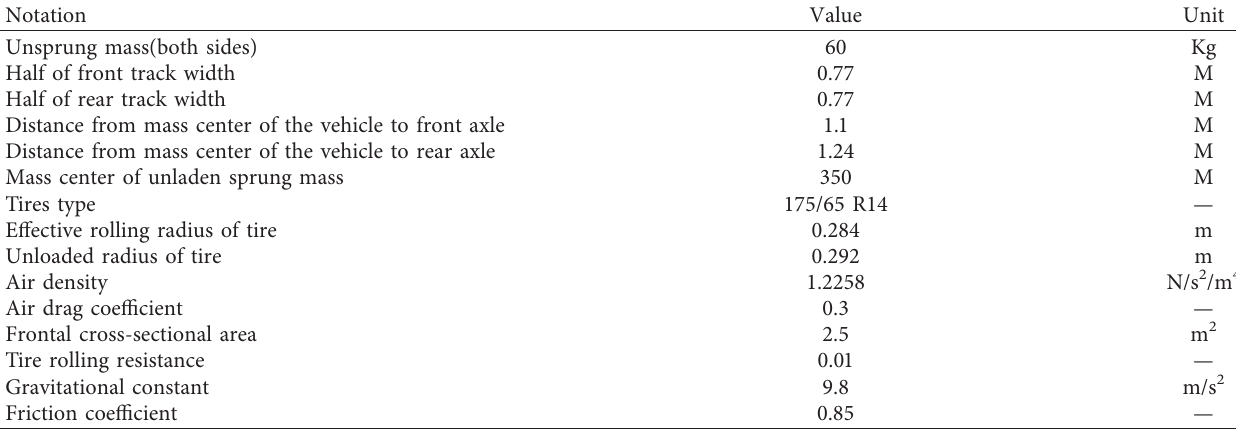
Table 2: Main parameters for the vehicle model established in